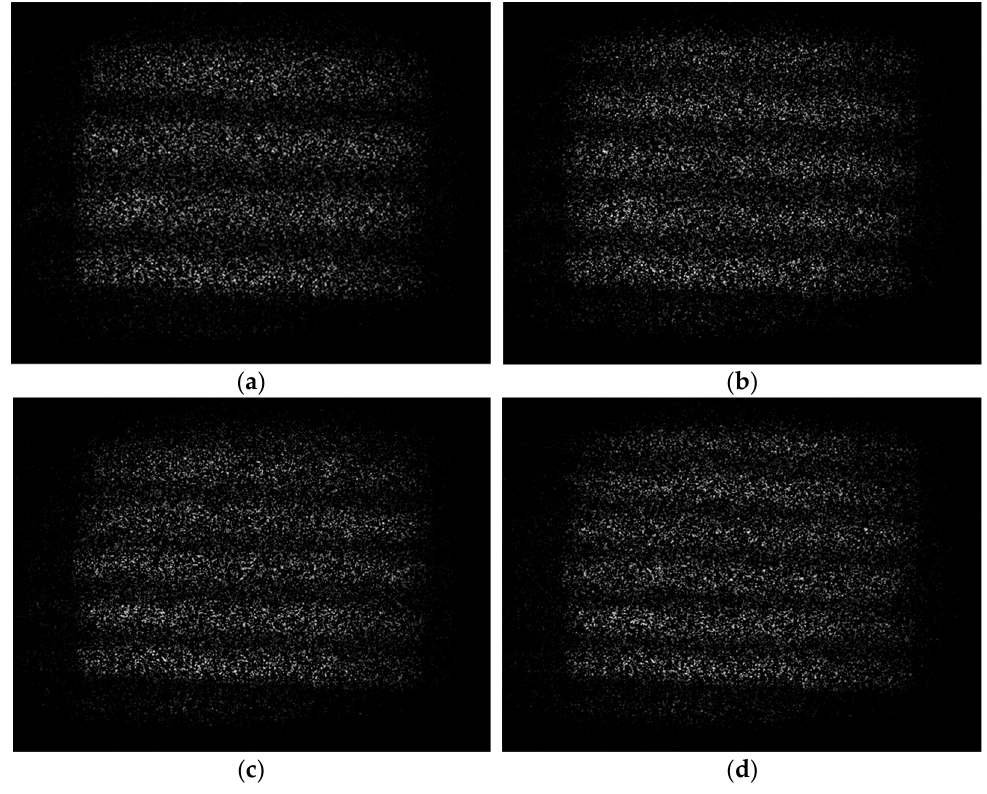
Figure 10. The interference fringe pattern obtained by the subtraction mode. ( a – d ) represent the 70th, 140th, 210th, and 280th speckle interferogram subtracting the first one, respectively.